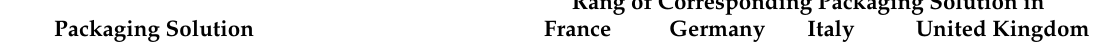
Table 1. Overview of the three top-rated and worst-rated packaging solutions adapted from Eriksson et al. [407] sorted by country. Rang of Corresponding Packaging Solution